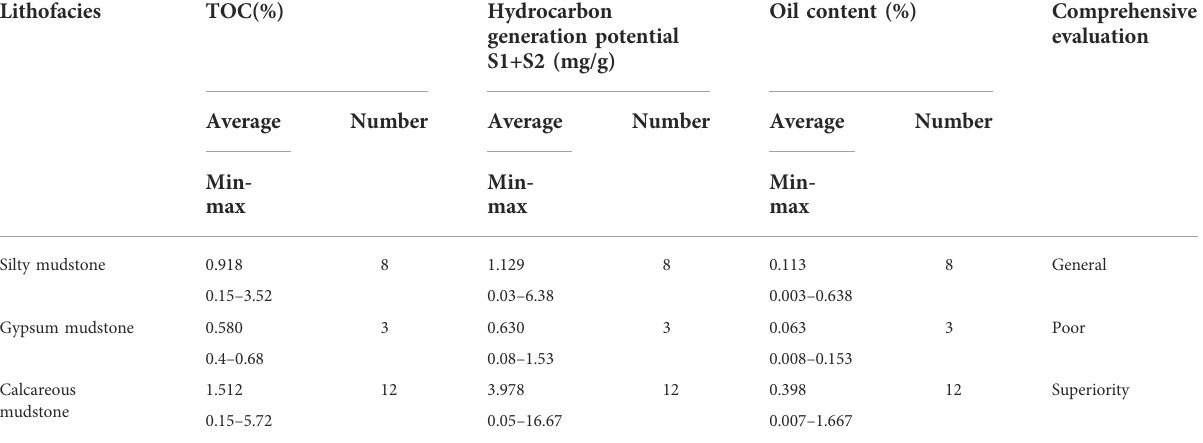
TABLE 4 Comprehensive evaluation of hydrocarbon generation potential of different lithofacies